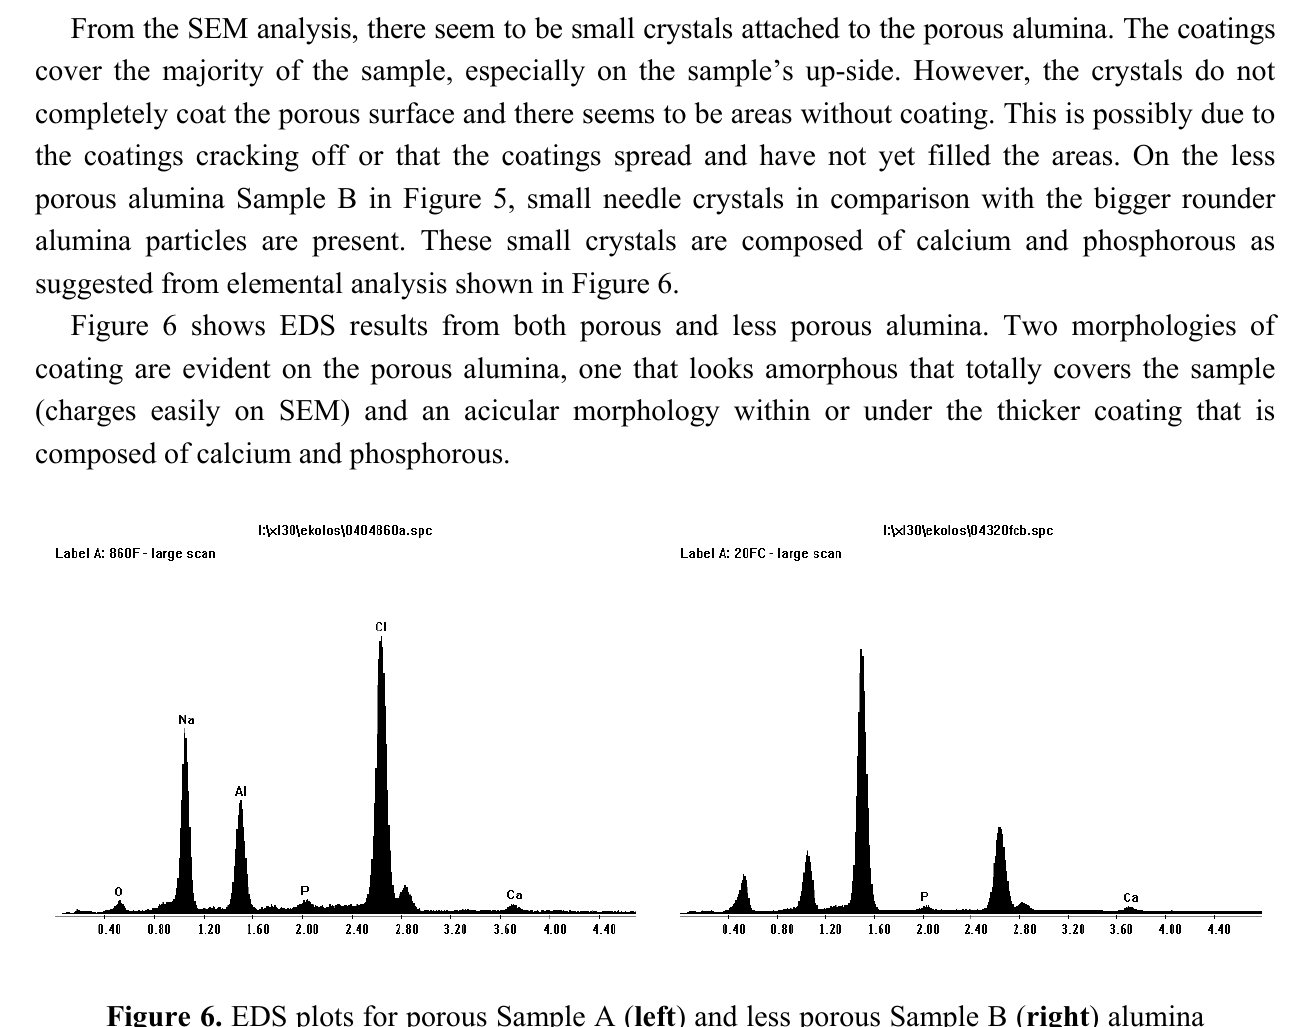
Figure 5. SEM micrographs of alumina after SBF soaking showing porous Sample A ( left ) and less porous Sample B ( right ) alumina. A coating is clearly visible.